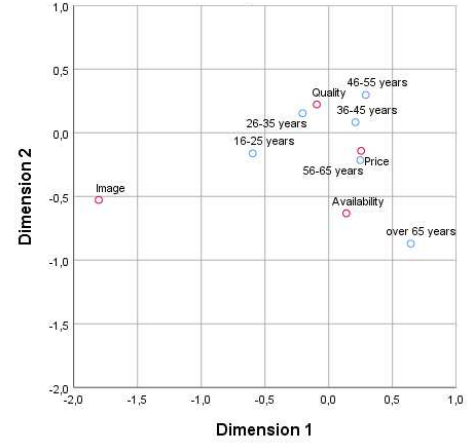
Figure 1. Correspondence map (Age/Motivation)